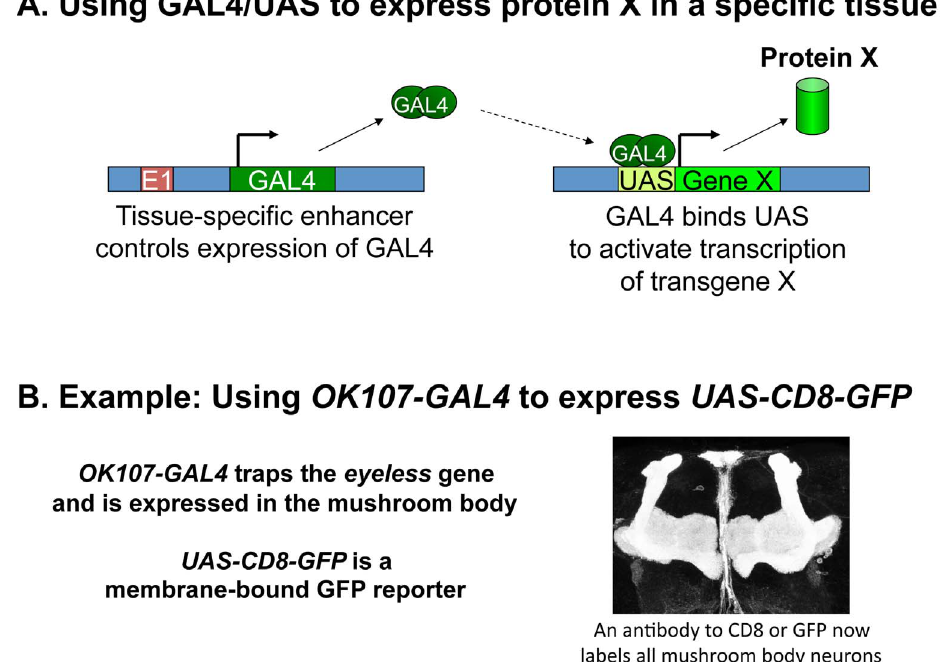
Fig. 1. The GAL4/UAS system. A. The GAL4/UAS system is a binary expression system in which transcriptional activator GAL4 is expressed in specific tissues by a nearby enhancer (E1), and GAL4 protein binds to engineered UAS sequences to drive the expression of a transgene X of choice in those tissues. B. For example, OK107-GAL4 traps an enhancer of the eyeless gene and is expressed in all intrinsic neurons of the mushroom body, allowing a membrane-bound reporter, UAS-CD8-GFP , to label those cells. E1: Enhancer. UAS: Upstream Activation Sequence. X: Gene of